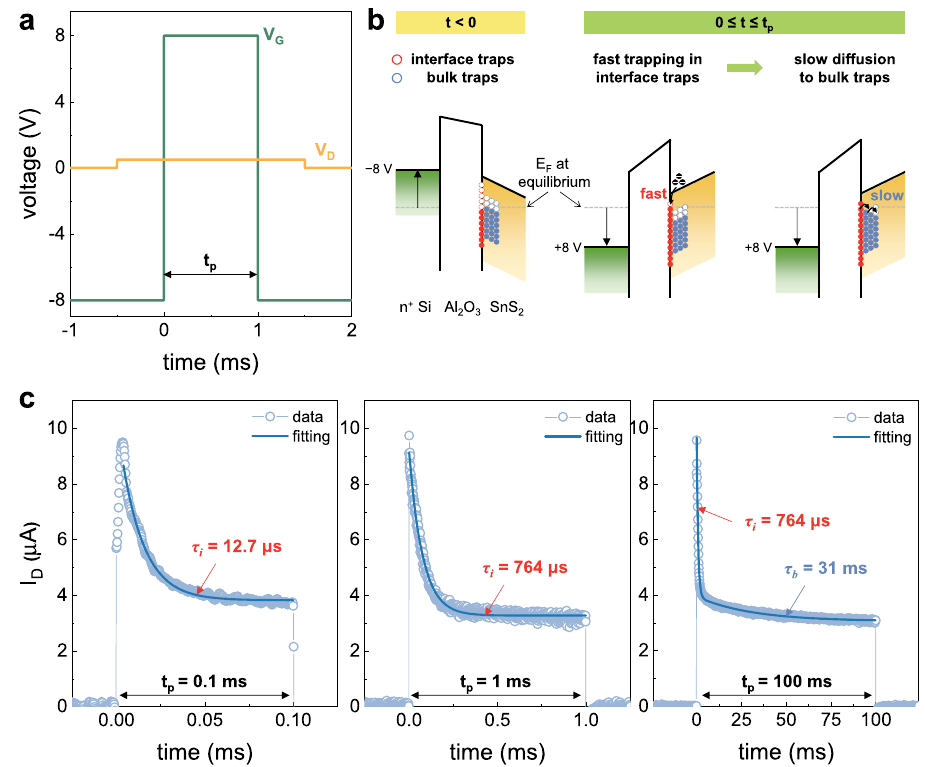
Fig. 3 Analysis of different trap time constants. a Schematic diagram of gate and drain pulses applied to the SnS 2 memtransistor for measuring I D transient. b Energy band diagram schematics showing the key mechanism responsible for the resistive switching. c I D transient results according to differing gate pulse durations ( t p ). Obtained short trap time constant ( τ i ) below 764 μ s is responsible for the interface trap. Meanwhile, a trap time constant ( τ b ) longer than tens of milliseconds is responsible for the bulk